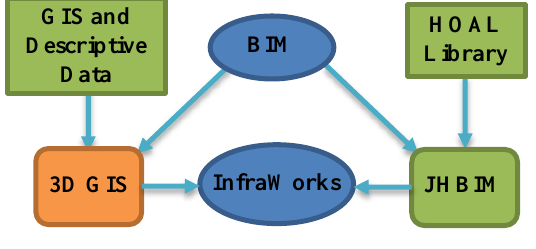
Figure 11: the concept of the integration between JHBIM and 3D GIS in Autodesk InfraWorks.